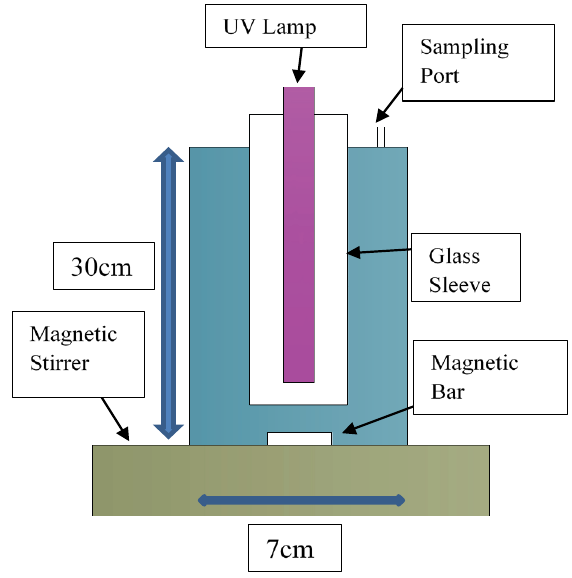
Figure 1. UV reactor setup layout as used for the LDH-TiO 2 PCD work.